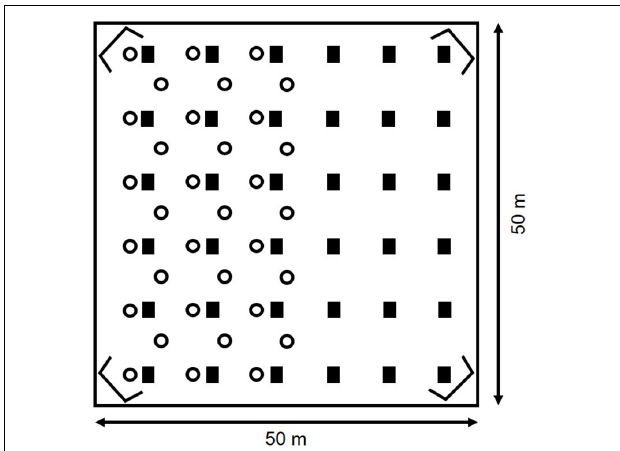
FIGURE 2 | Naturally vegetated outdoor enclosure with partial nighttime illumination. Artificial light at night was created using small LED garden lamps (circles). Multicapture live traps were evenly distributed across each enclosure (black boxes). A 24 h radio telemetry was conducted during half moon and new moon using Yagi antennae in the corners of the enclosure connected to an automatic receiving unit.